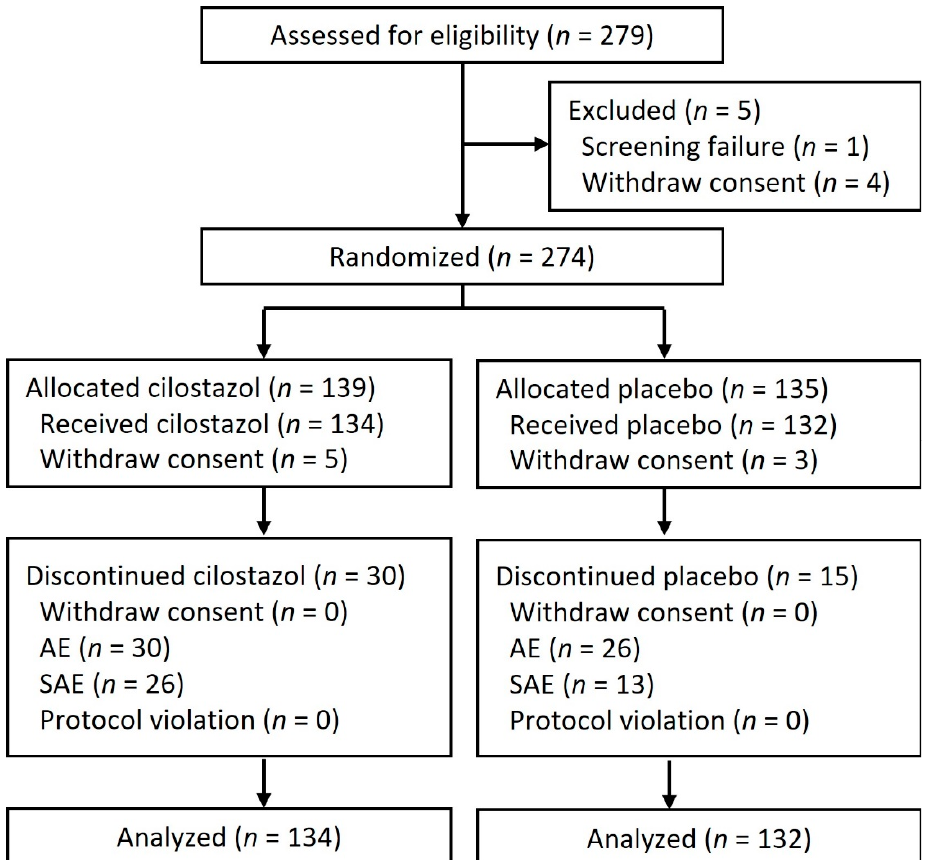
Figure 1. Participant flow diagram. AE, adverse event; SAE, severe adverse event. The average age was 64.5 years in the cilostazol group and 67.2 years in the placebo group. Males dominated in both groups (77.6% in cilostazol group and 68.9% in placebo group). Most of the baseline characteristics were similar between cilostazol and placebo groups, except participants in the cilostazol group were younger and more of them had peripheral artery disease, coronary bypass surgery, anemia, and use of aspirin. Most subjects had stable CAD (76.9% in the cilostazol group and 73.5% in the placebo